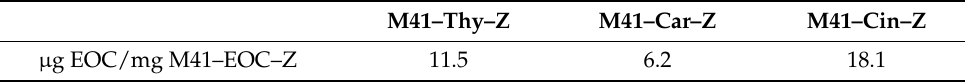
Table 2. Extracted content of cargo in the final solids ( μ g EOC/mg M41–EOC–Z).